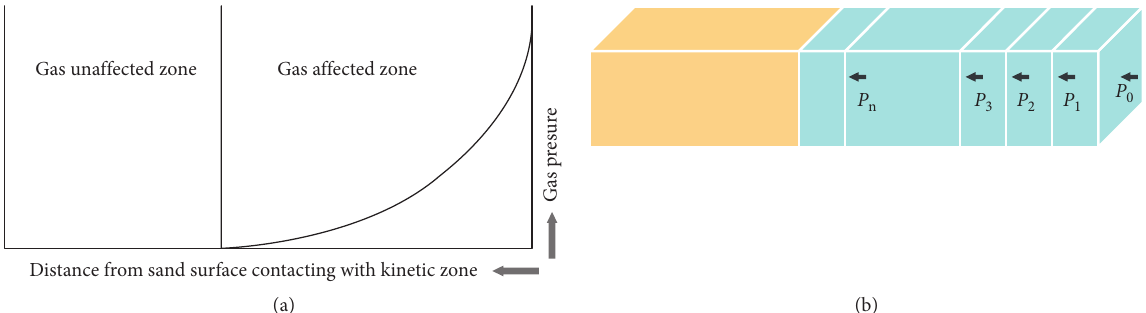
Figure 6: Schematic illustration showing (a) sand plate and (b) distribution of the gas pressure near the kinetic zone.